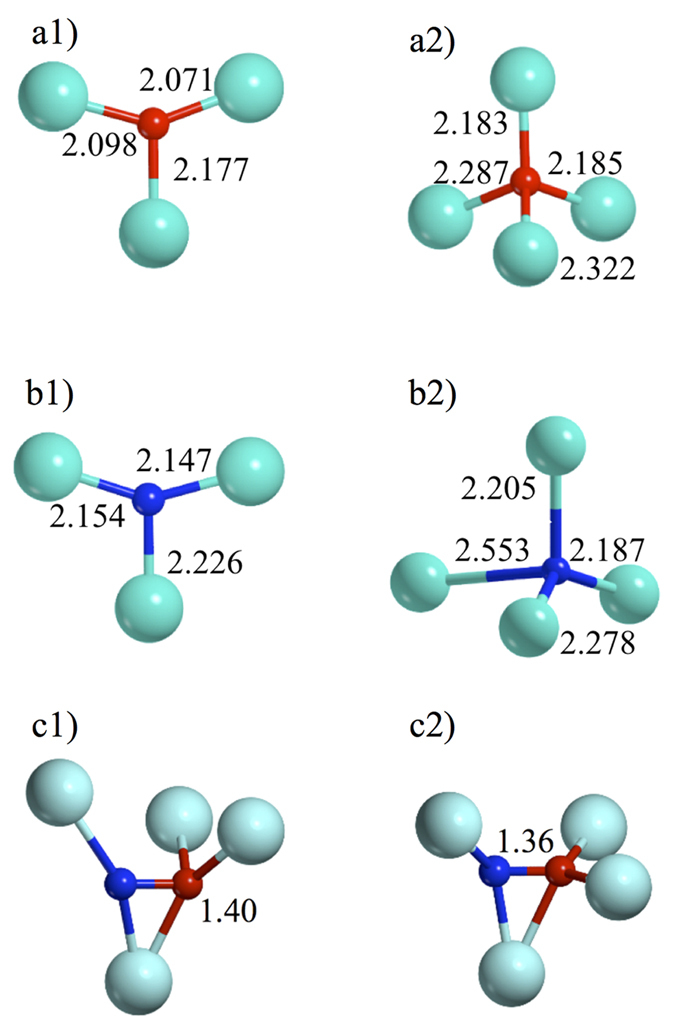
Local structural features of pure ZrO2 (a1, a2) and the four N-doped ZrO2 structure.(b1) Nsub3c; (b2) Nsub4c; (c1) Nint3c and (c2) Nint4c. Selected bond lengths (Å) are reported.